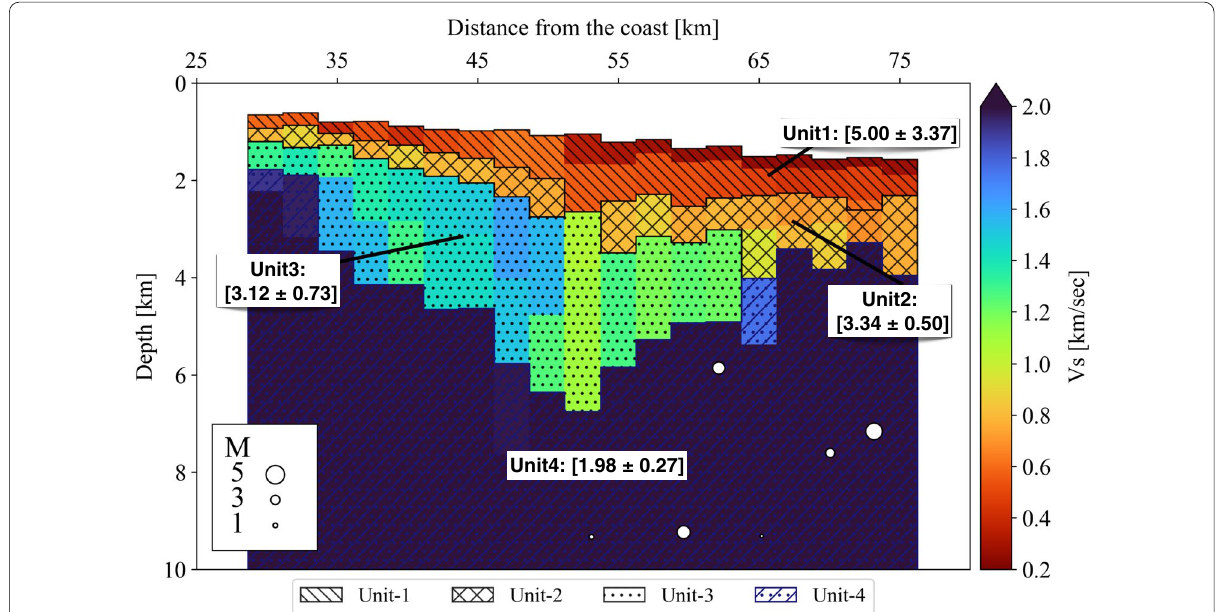
Fig. 4 2-D V s structure estimated from phase velocity information. 2-D V s structure estimated from phase velocity information. The 2-D structure model consists of four units. Unit annotations are the average V p/ V s value with errors. The errors were defined as double standard deviation during calculation of average. The white circles indicate the aftershocks off the Pacific coast of the Tohoku Earthquake determined by pop-up OBSs (Shinohara et al., 2012). The aftershocks within a box of 40 km in width on both sides along the fiber cable are projected onto this profile. Some aftershocks occurred in Unit4, whereas there was no seismicity observed in the sedimentary